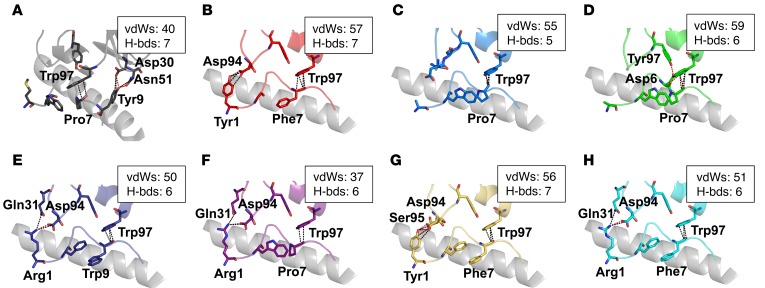
The 1E6 TCR makes distinct peptide contacts with peripheral APL residues.Interactions between the 1E6 TCR and peptide residues outside of the conserved GPD motif. The MHCα1 helix is shown in gray illustrations. Hydrogen bonds are shown as red dotted lines; van der Waals (vdW) contacts are shown as black dotted lines. Boxes show total contacts between the 1E6 TCR and each peptide ligand. (A) Interaction between the 1E6 TCR (black illustration and sticks) and A2-MVWGPDPLYV (black illustration and sticks). (B) Interaction between the 1E6 TCR (red illustration and sticks) and A2-YLGGPDFPTI (red illustration and sticks). (C) Interaction between the 1E6 TCR (blue illustration and sticks) and A2-ALWGPDPAAA (blue illustration and sticks) reproduced from previous published data (21). (D) Interaction between the 1E6 TCR (green illustration and sticks) and A2-AQWGPDPAAA (green illustration and sticks). (E) Interaction between the 1E6 TCR (dark blue illustration and sticks) and A2-RQFGPDWIVA (dark blue illustration and sticks). (F) Interaction between the 1E6 TCR (purple illustration and sticks) and A2-RQWGPDPAAV (purple illustration and sticks). (G) Interaction between the 1E6 TCR (yellow illustration and sticks) and A2-YQFGPDFPTA (yellow illustration and sticks). (H) Interaction between the 1E6 TCR (cyan illustration and sticks) and A2-RQFGPDFPTI (cyan illustration and sticks).